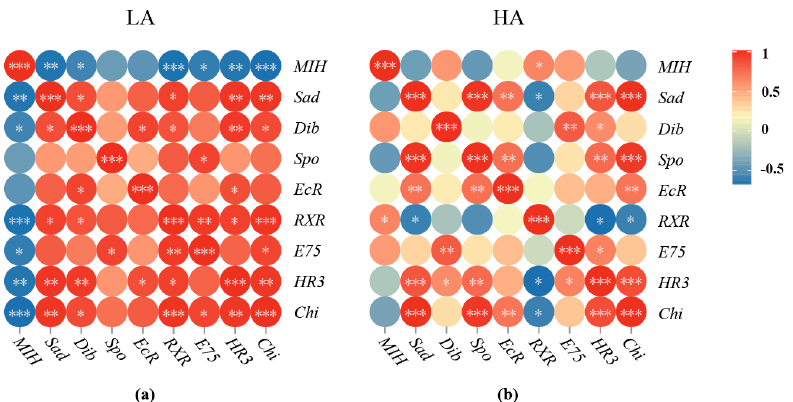
Figure 7. Correlation analysis of the moulting signals in the juvenile crabs under ammonia nitrogen stress. ( a ) correlation analysis for the LA group; ( b ) correlation analysis for the HA group. * represents a significant difference between two genes ( p < 0.05), ** represents p < 0.01, and *** represents p < 0.001.